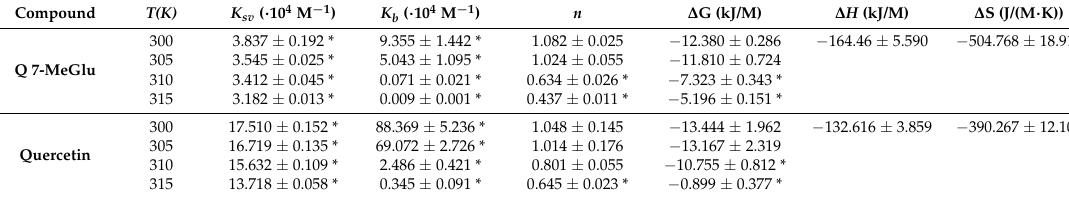
Table 4. Quenching ( K sv ) and binding ( K b ) constants and thermodynamic parameters ( n , ∆ G , ∆ H and ∆ S ) of quercetin 7- O - β - D -(4”- O -methyl)glucopyranoside (Q 7-MeGlu) and quercetin and human serum albumin at different temperatures. Means labelled with asterisk (*) are significant ( p < 0.05). Compound T(K) K sv ( · 10 4 M − 1 ) K b ( · 10 4 M − 1